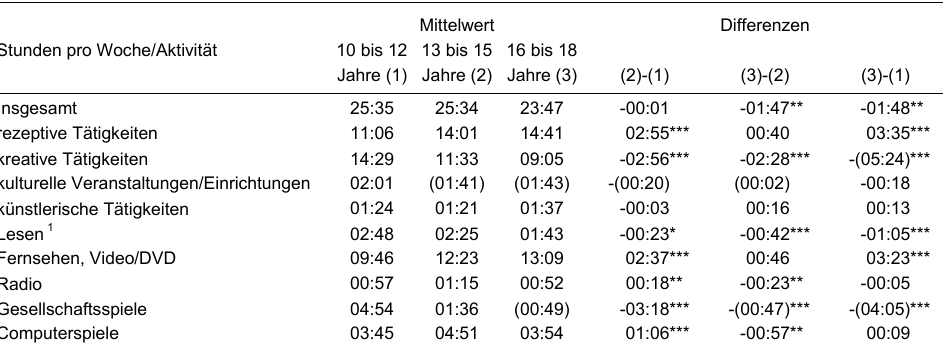
Tabelle 5 : Zeitverwendung für kulturelle und musisch-ästhetische Aktivitäten von Kindern nach Altersgruppen (in Stunden und